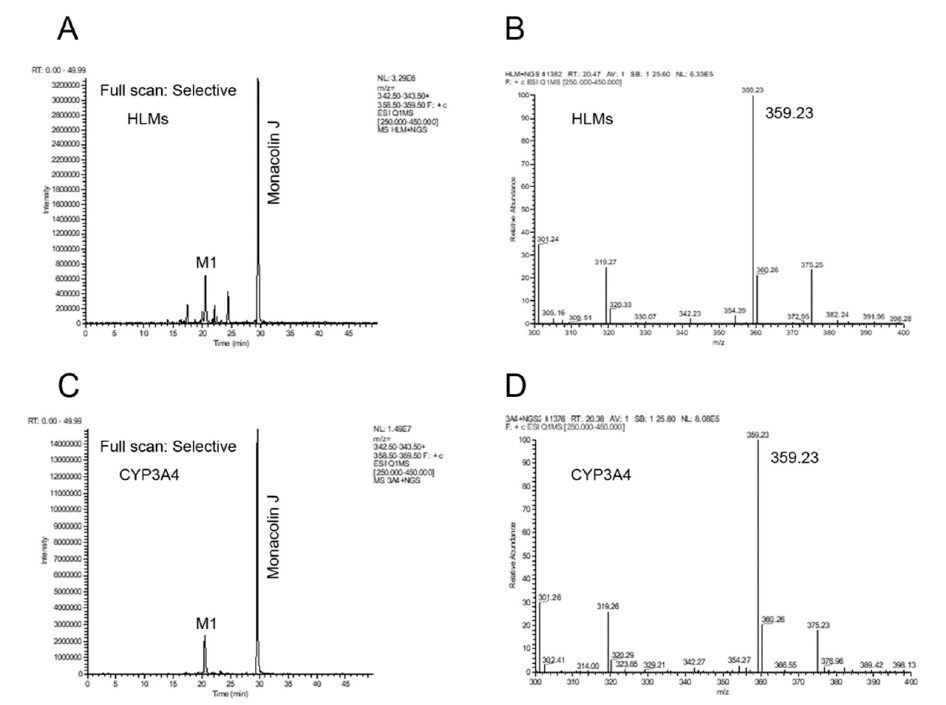
Figure 8. LC–MS results of the metabolite of monacolin J when using HLMs and CYP3A4. LC–MS chromatogram of monacolin J that was catalyzed using HLMs ( A ) and CYP3A4 ( C ) in the presence of NADPH. The MS spectra demonstrated that the m / z value of the protonated molecular ion of the major product from both of HLMs ( B ) and CYP3A4 ( D ) was 359, which is the same as that produced with M697.